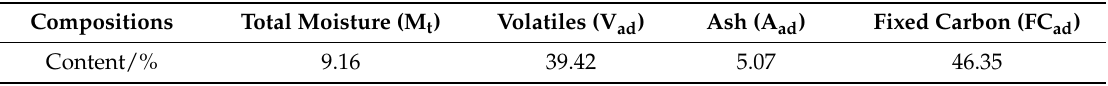
Table 2. Proximate analysis of the coal used. Table 2 . Proximate analysis of the coal used.